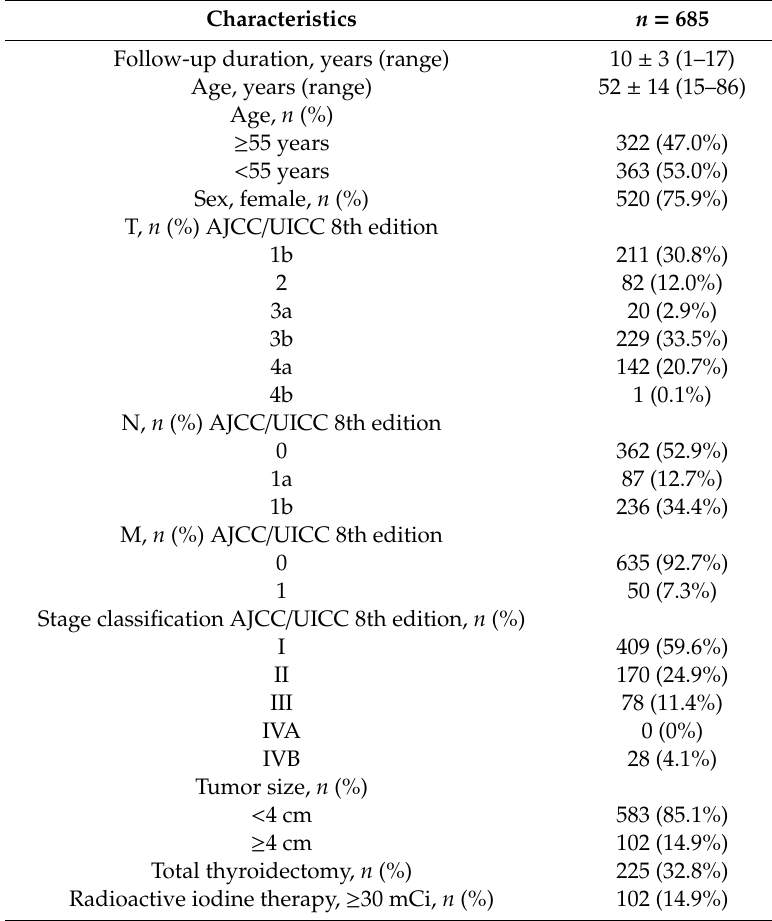
Table 1. Baseline characteristics of